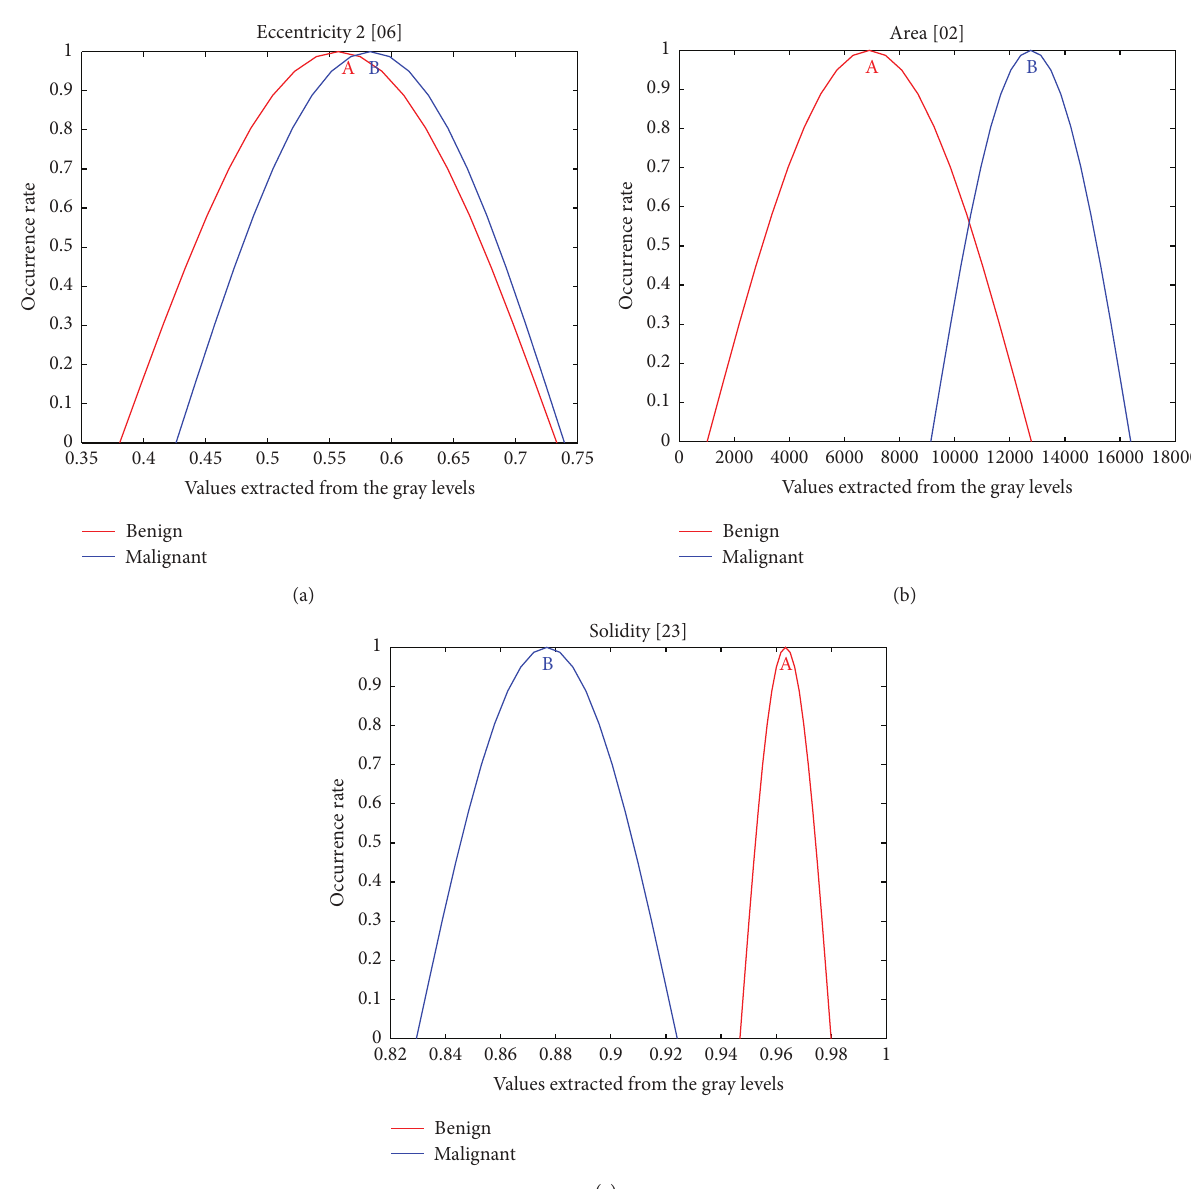
Figure 4: Gaussian distribution curves: (a) almost full overlapping, (b) partial overlapping, and (c) without overlapping between the